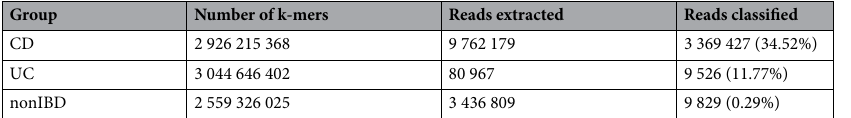
Table 2. Taxonomic annotation of k-mer-based reads. Only k-mers identified by the best SC1 performer were used for reads